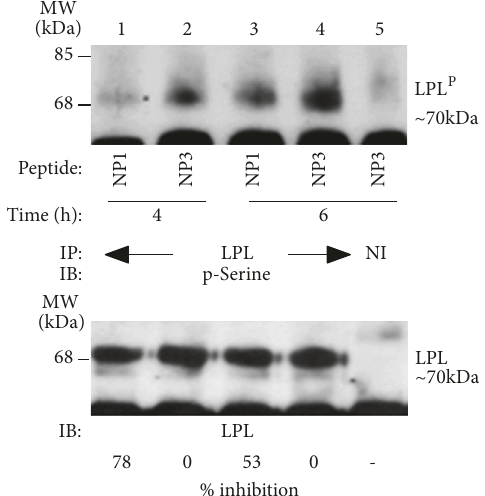
Figure 4: Immunoblotting (IB) analysis of the time-dependent effect of NP1 and NP3 on the phosphorylation of endogenous LPL . The equal amount of lysates made from osteoclasts treated with NP1 (lanes 1 and 3) and NP3 (lanes 3 and 4) for 4h (lanes 1 and 2) and 6h (lanes 3 and 4) was used for immunoprecipitation (IP) with an LPL antibody. IP with a nonimmune serum is shown in lane 5. Immunoprecipitates were subjected to IB with an antibody to p- Serine (top panel). Blot was stripped and reprobed with an antibody to LPL (bottom panel). Percent inhibition of phosphorylation of the representative experiment with NP1 is 78% at 4h and 53% at 6h as compared with corresponding NP3 control in lanes 2 and 4. These results representone of the two experiments performed with similar